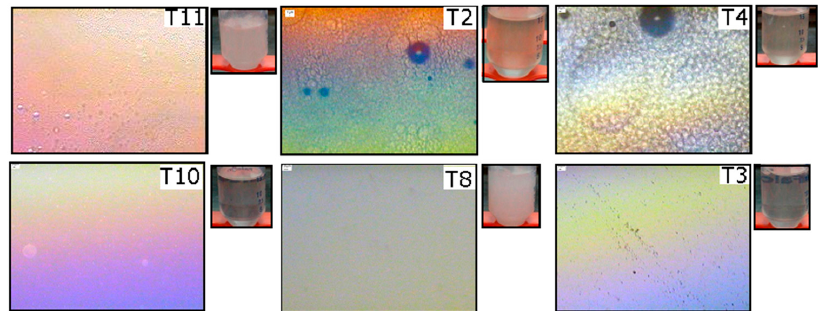
Figure 3. Optical microscope images, with crossed polarizers at 5× magnification, of the ME corresponding to the OP//TW80//AP system at T = 25 °C. corresponding to the OP//TW80//AP system at T = 25 ◦